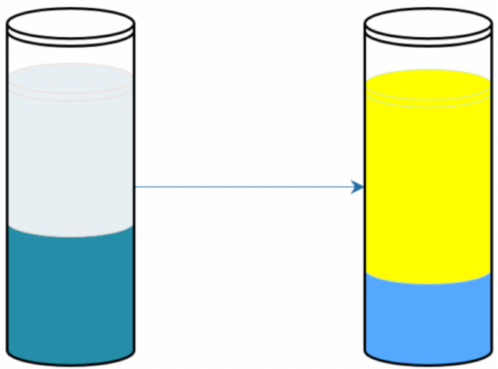
Figure 11. Transesterification’s reaction procedure.